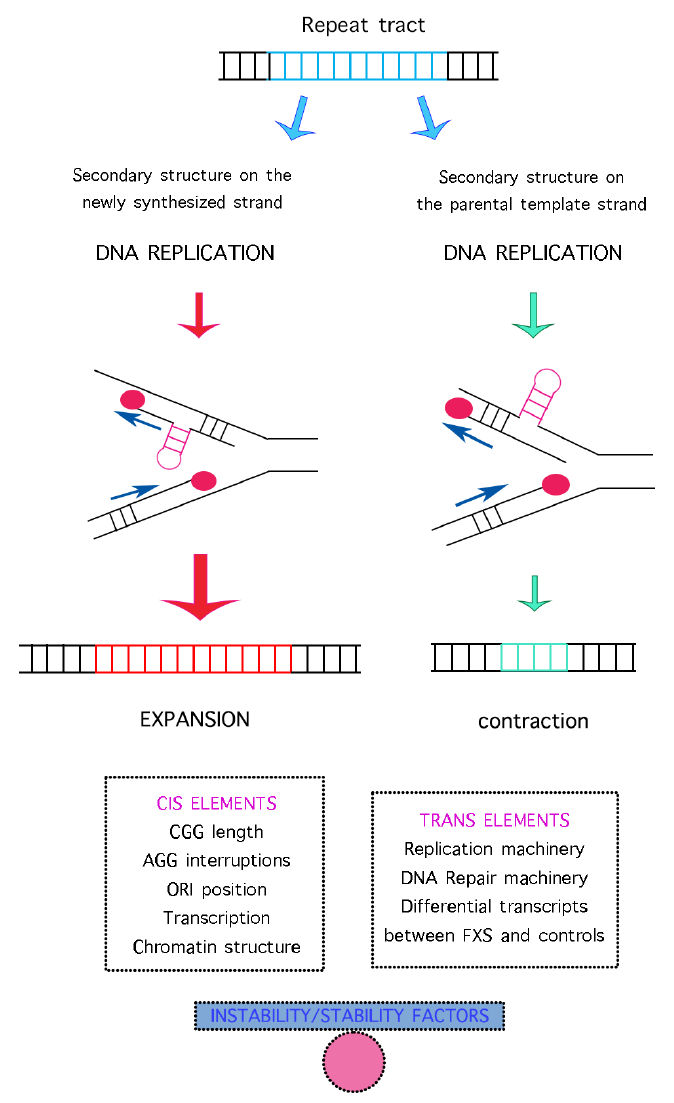
Figure 4. Factors that influence expansion and contraction events during DNA replication at the CGG repeat. The presence of the repeated CGG sequence (blue bars) on the nascent strand induces the formation of hairpins or other secondary structures. At the end of a second round of replication, an expansion (red bars) will result (on the left), whereas the presence of similar secondary structures on the template strand results in a stall with a late restart of the DNA polymerase that causes the exclusion of the repeated tract included in the secondary structure, thus leading to contraction events (green bars) after the second round of replication (on the right). The balance between listed cis and trans elements will hold the repeat sequence stable. An imbalance of these factors will favor instability (contractions or